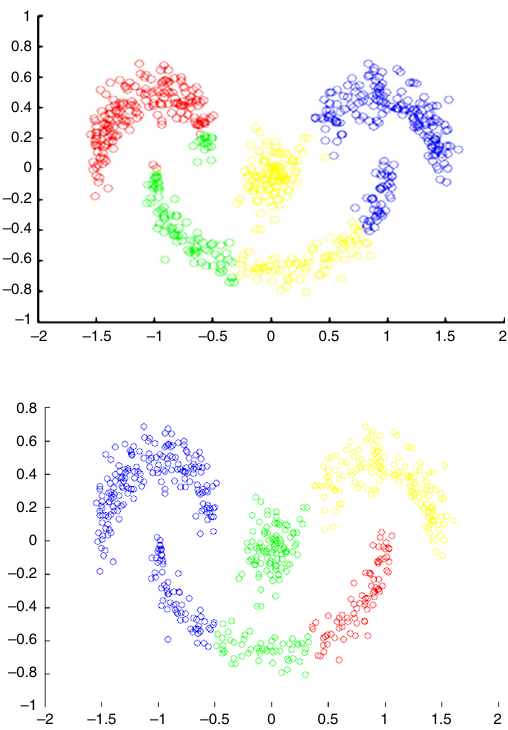
Figure 5. Result of average- link on “ Smileface ” data